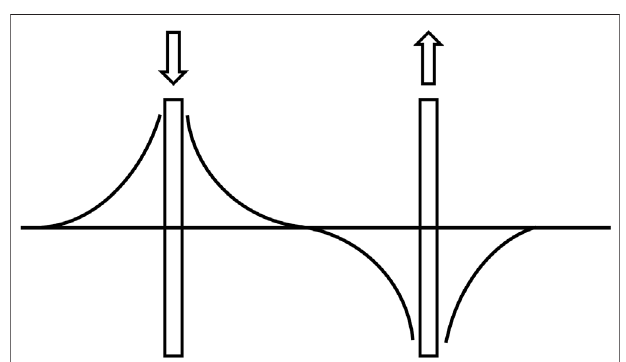
FIGURE 11 | CO 2 fl ooding pressure drop funnel.